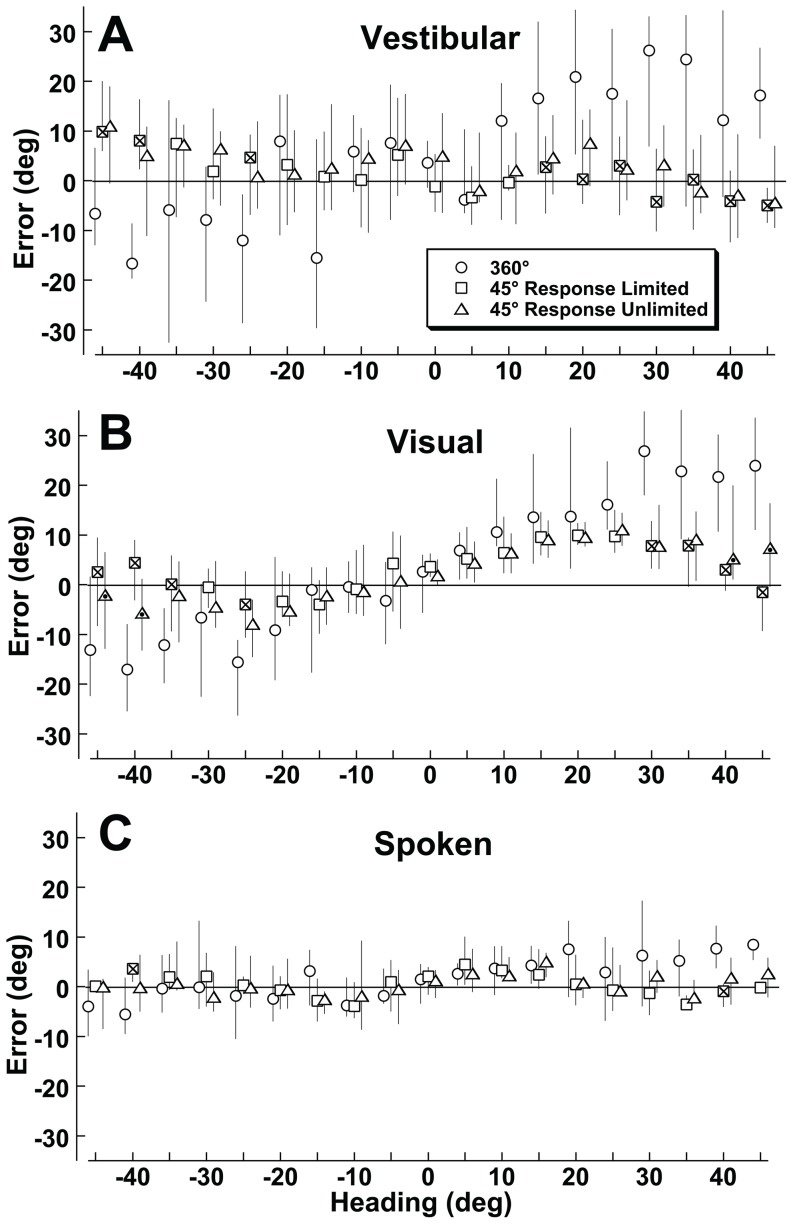
Effect of limiting headings to ±45°.In a subset of 6 subjects (#1,2,3, 7, 8, and 9) the task was repeated with the possible headings limited to ±45°. This task was initially done with the responses mechanically limited to ±45° (squares) and subsequently in the same session with the full range of responses available (triangles). Each data point represents the median response with error bars representing 25th to 75th percentiles. The responses with a full range of possible headings and responses are shown as circles, these are the same responses plotted in Fig. 1 but for the subset of subjects who also completed the limited heading task. Squares marked with ‘X’ indicate the perceived headings during the 45° response limited condition were significantly different than the perceived headings when the full range of headings was delivered. Triangles marked with dots indicate a significant difference (p<0.01) between conditions where the responses were limited to ±45° and the condition where only the headings were limited to ±45°, this was uncommon and limited to the visual stimulus for headings of ±40° and ±45°.